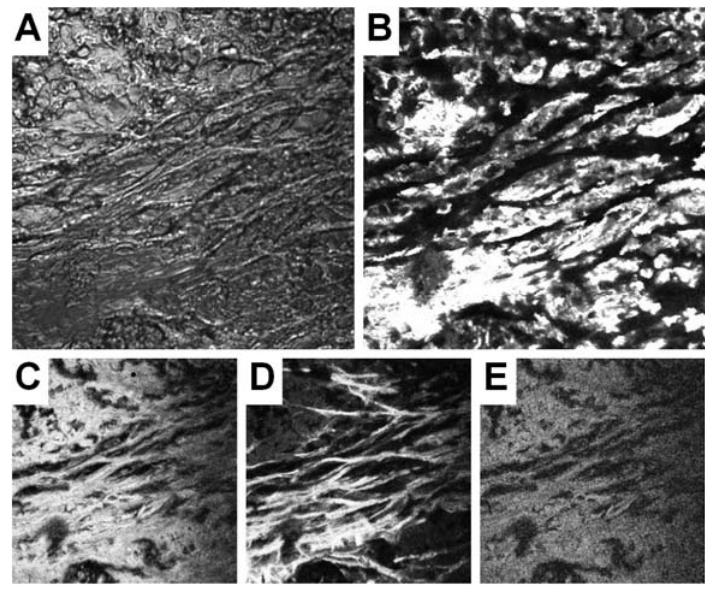
Figure 6. Complementary epi-detected confocal images from the same 212 μ m square region of a 20 μ m thick sample of cancerous breast tissue. (a) Differential interference contrast (DIC), (b) CARS tuned to 1,662 cm − 1 , (c) two-photon fluorescence (2PEF), (d) second harmonic generation (SHG), (e) sum frequency generation (SFG). Images (b) and (e) were acquired simultaneously, with 11 mW of 1,064.4 nm and 16 mW of 904.4 nm (measured at the sample), all other images were acquired sequentially with illumination only at 904.4 nm. All pixel dwell times were 61 μ s (except ‘a’: 1.7 μ s), and all images were 512 × 512 pixels. The scan unit dichroic mirror was at 870 nm, the dichroic mirror in the filter block (Photomultiplier detector unit) was at 670 nm. Further short pass filters were applied before ‘b’ (800 nm) and ‘c’, ‘d’, ‘e’ (660 nm). Band pass filters were at 800 nm (width 30 nm) in ‘b’, 535 nm (width 30 nm) in ‘c’, 460 nm (width 50 nm) in ‘d’, 480 nm (width 30 nm) in ‘e’. © John Wiley & Sons,